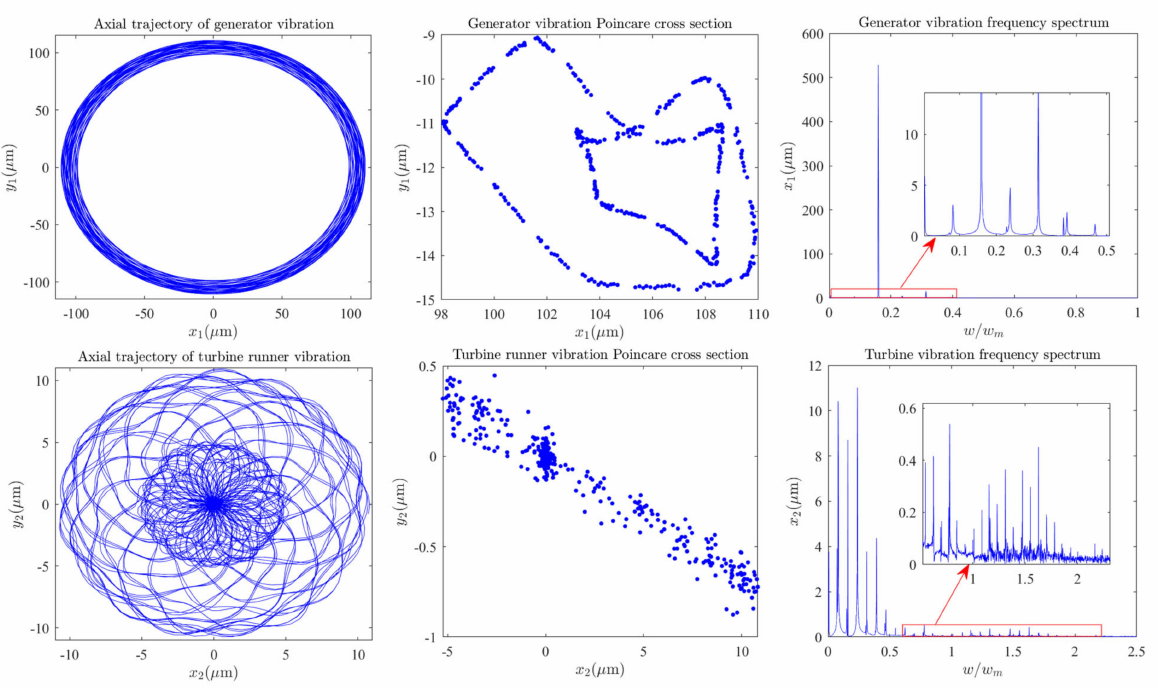
Figure 3. Dynamic characteristics of the shafting